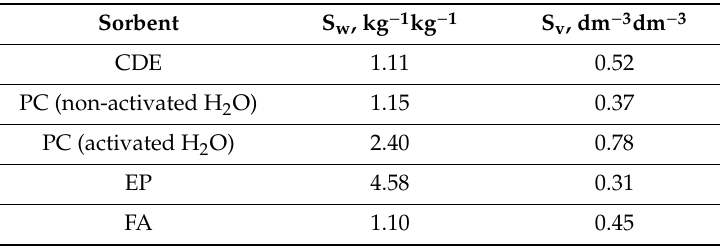
Table 2. Maximal sorptivity relative to benzene expressed in [g/g] and [dm 3 /dm 3 ] for MgO-TiO 2 neutralizer (FA) and selected sorbents used in rescue operators during uncontrolled release of chemical substances (CDE, PC, EP).